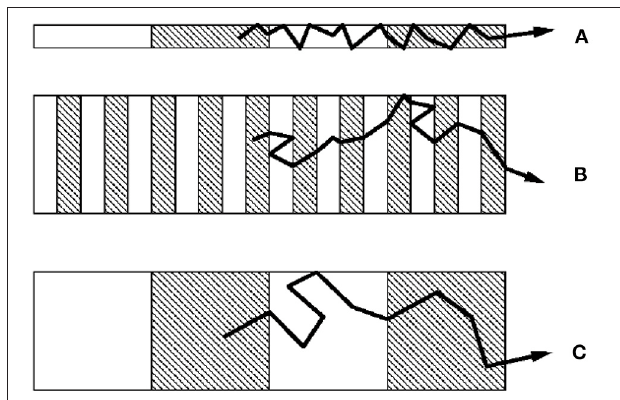
FIGURE 8 | Dominating scattering mechanisms in superlattice NWs (A) diameter limited; (B) superlattice limited; (C) bulk limited. Reprint from Dames and Chen